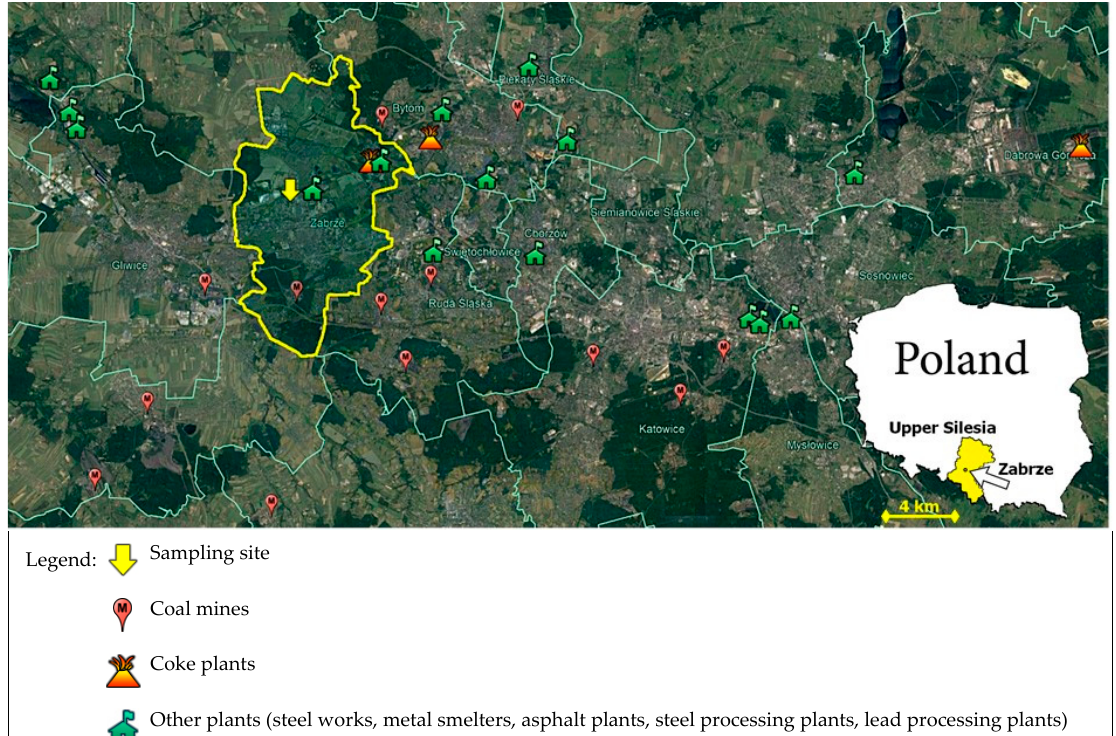
Figure 1. Location of the air-quality monitoring station in Zabrze (Poland).